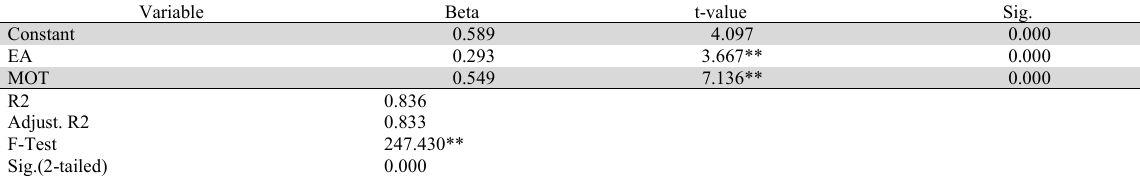
Summary of Regression